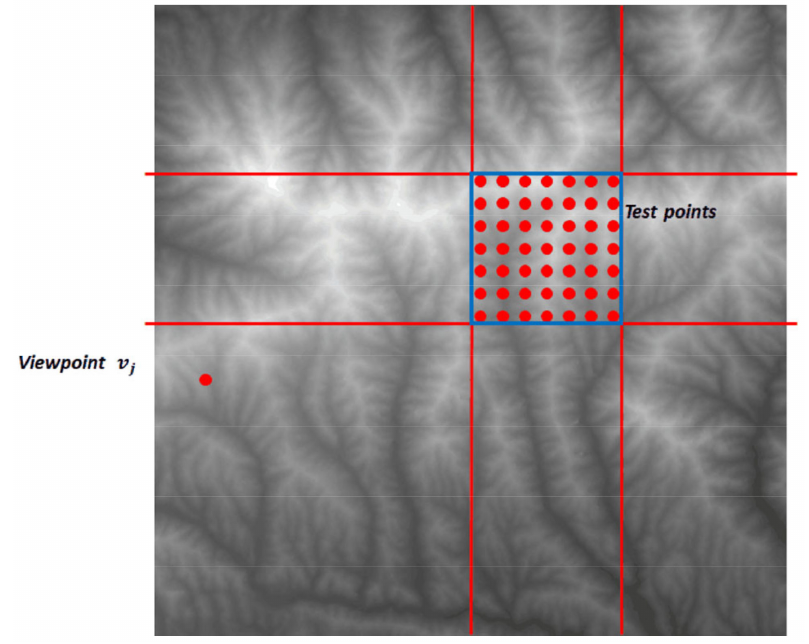
Figure 4. Test points. There are 7 × 7 test points in